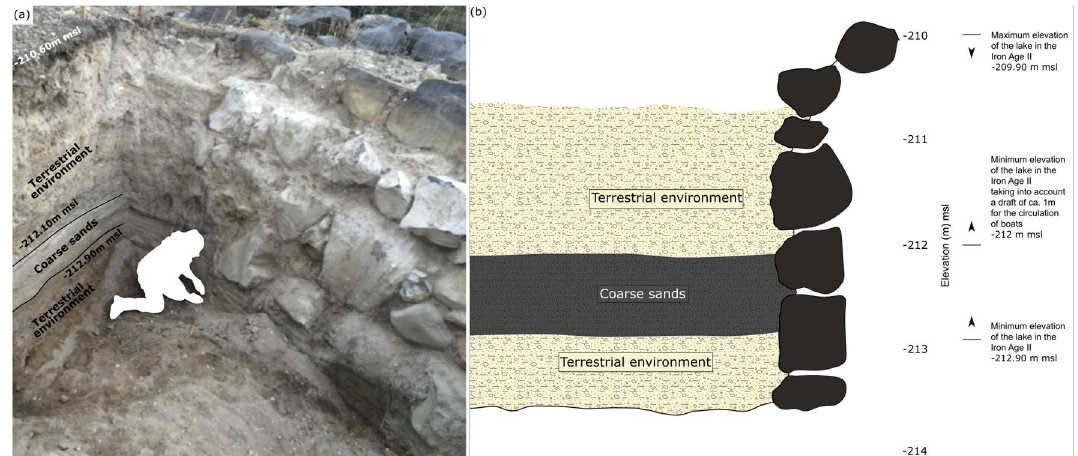
Figure 3. The breakwater. ( a ) Photo of the trench in the inner face of the breakwater and ( b ) drawing of the sedimentary units with estimated ancient lake level elevation. The three environmental units have been differentiated by their sedimentary texture and color (details of the sedimentary units are given in Supplementary